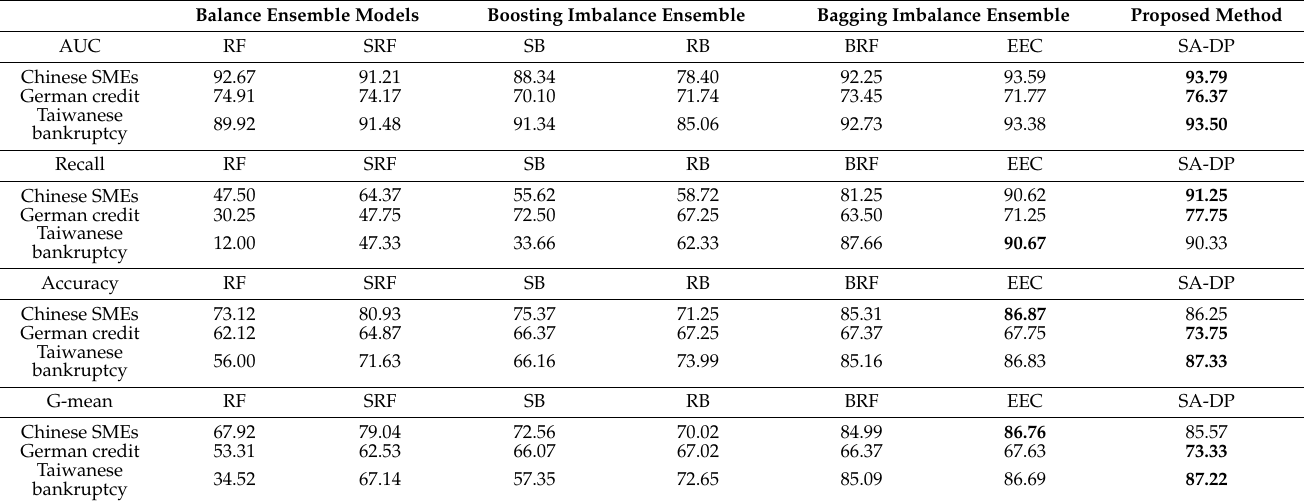
Table 8. Evaluation of model performance on credit risk datasets (%), the bold represent the optimal